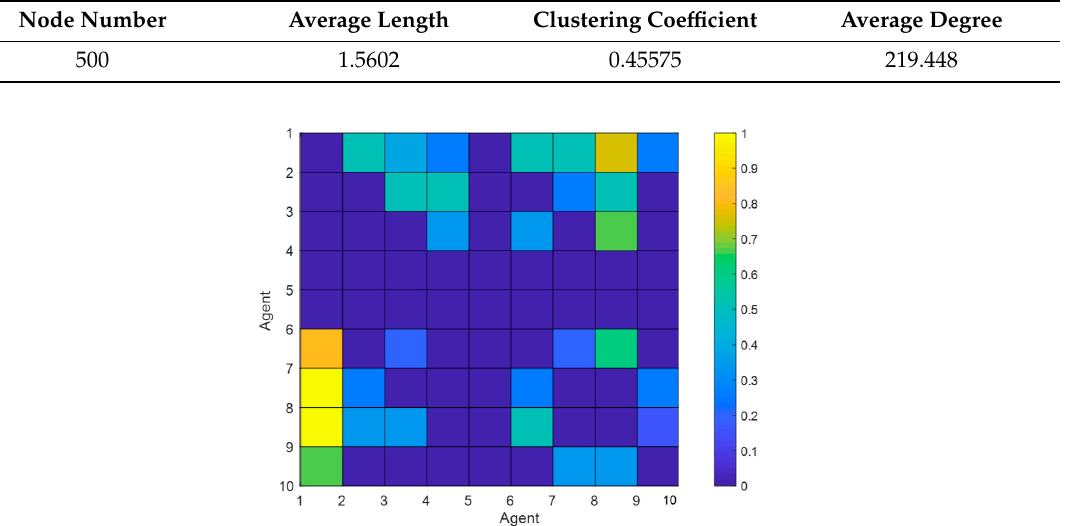
Table 1. Network parameters.